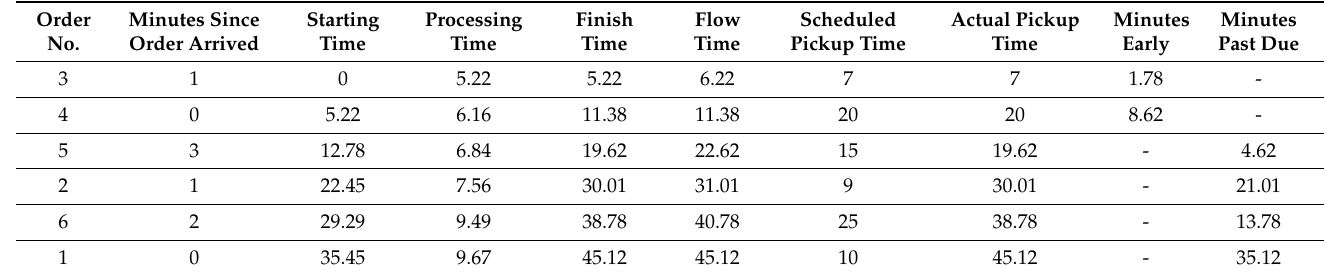
Table 5. Sequence of orders based on SPT